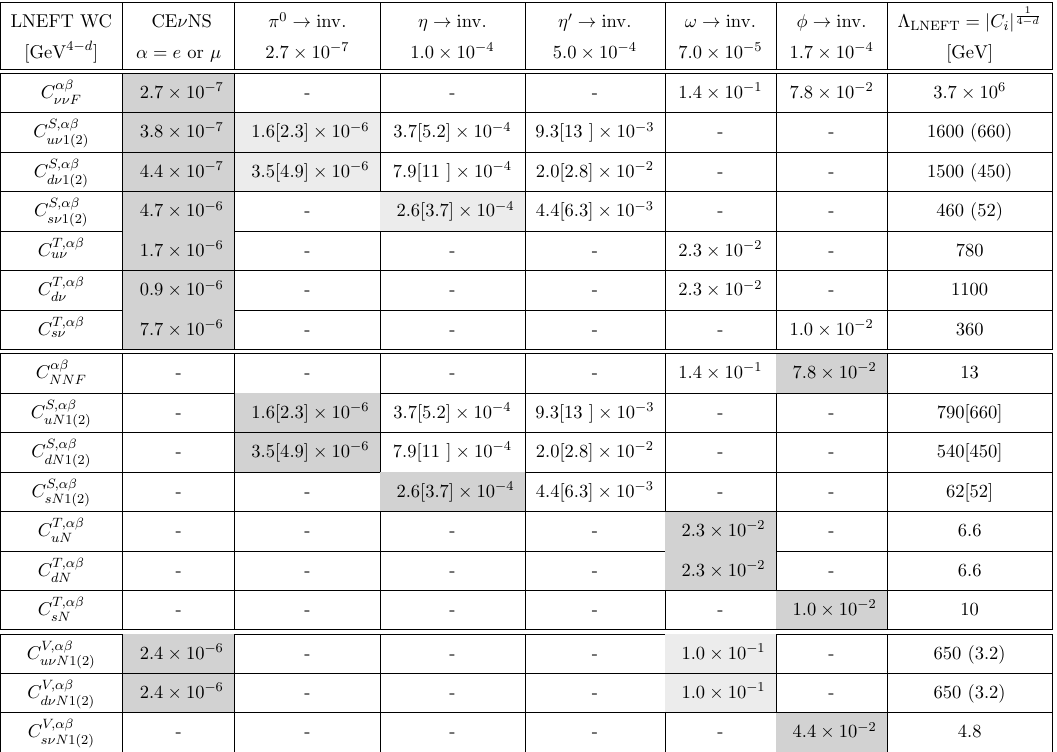
Table 4 . Constraints on the Wilson coe(cid:14)cients of the LNV operators in the LNEFT. For the scalar type operators, the numbers outside [inside] the square bracket indicate the case with the neutrino (cid:13)avors (cid:11) 6 = (cid:12) [ (cid:11) = (cid:12) ]. Note that the Wilson coe(cid:14)cients C S;(cid:28)(cid:28) in the last sector can not be constrained by CE (cid:23) NS. The strongest constraints on them are from the meson decays marked by the light gray cells, and the corresponding e(cid:11)ective scale is shown in parentheses (. . .